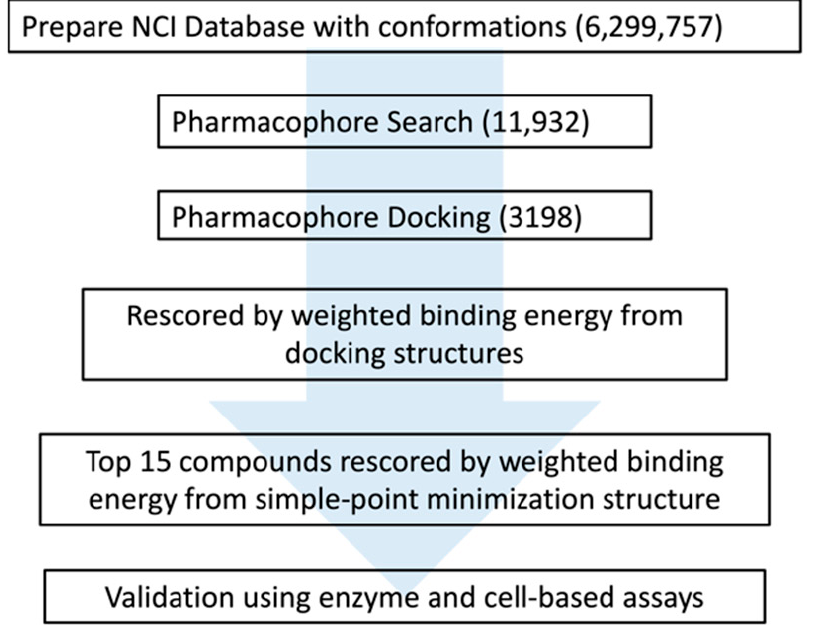
Figure 5. The workflow of proposed combinatorial virtual screening in this study. From NCI